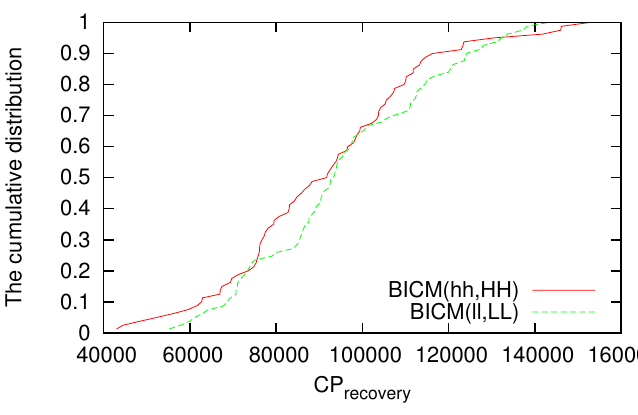
Figure 5. Cumulative distribution of the number of control packets ( CP recovery ) when nodes are removed by random failure.